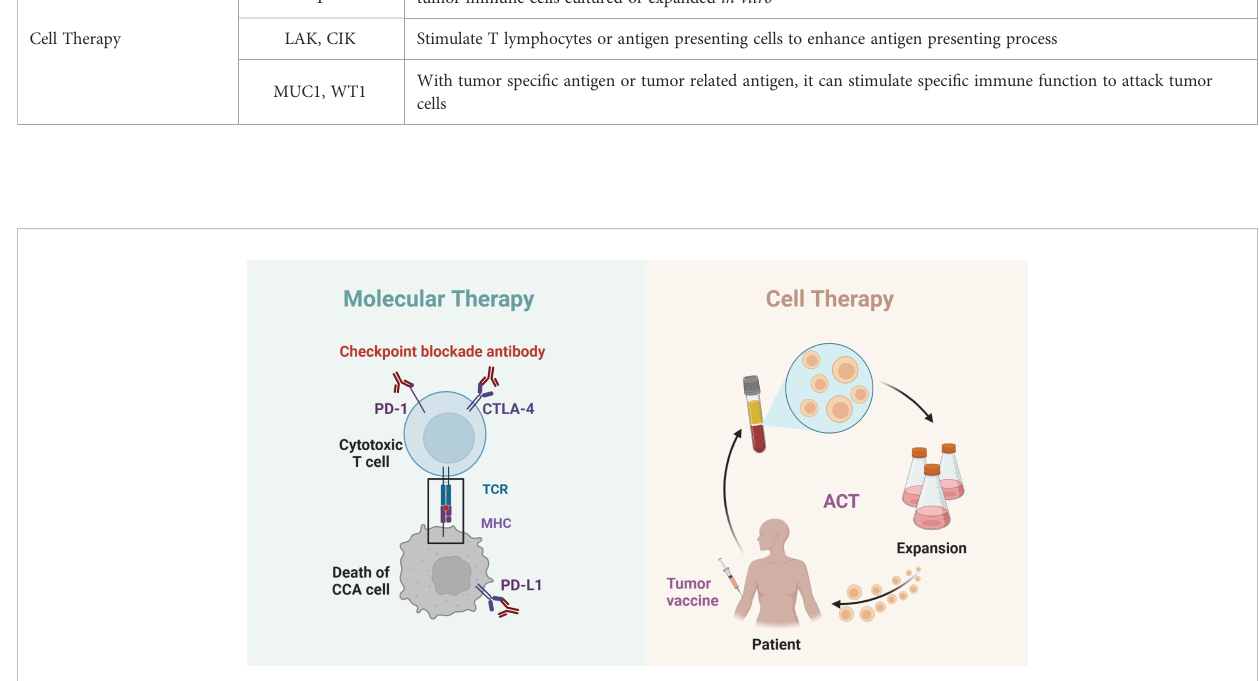
FIGURE 1 Schematics of molecular and cell therapy in cholangiocarcinoma. The interaction of PD-1/PD-L1 and CTLA4 with cholangiocarcinoma immunotherapy (left); The interaction of tumor vaccine and ACT with cholangiocarcinoma immunotherapy (right).